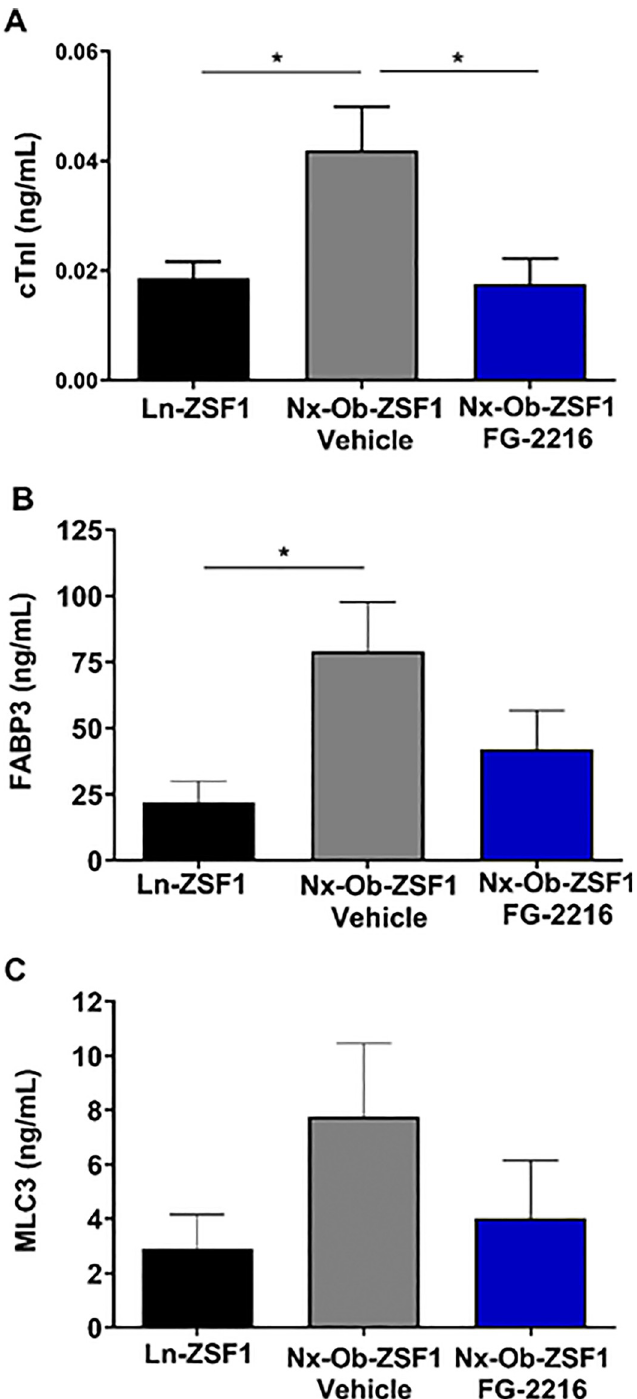
Fig 9. FG-2216 decreased plasma markers of cardiac injury in Nx-Ob-ZSF1 rats. Blood was collected after 16 weeks of treatment to measure plasma concentrations of cardiac troponin I (cTnI) ( A ), fatty acid binding protein 3 (FABP3) ( B ), and myosin light chain 3 (MLC3) ( C ). Values represent mean ± SEM (n = 8–12). � P < 0.05 vs . Nx-Ob-ZSF1 Vehicle (Dunnett’s test).